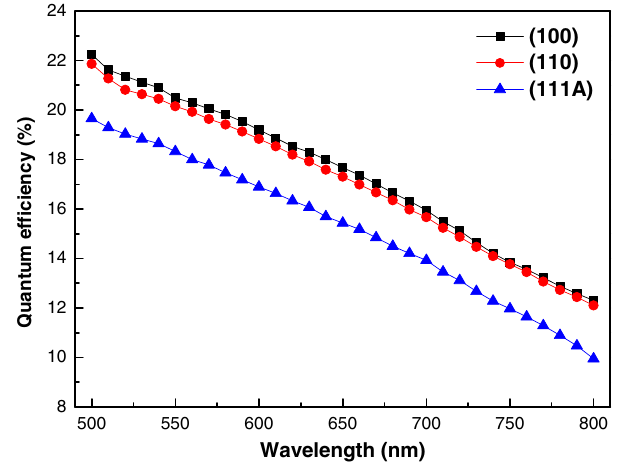
FIG. 6. Photocathode QE versus laser wavelength for commer- cial bulk GaAs samples with different surface cleave planes, prior to ion implantation.